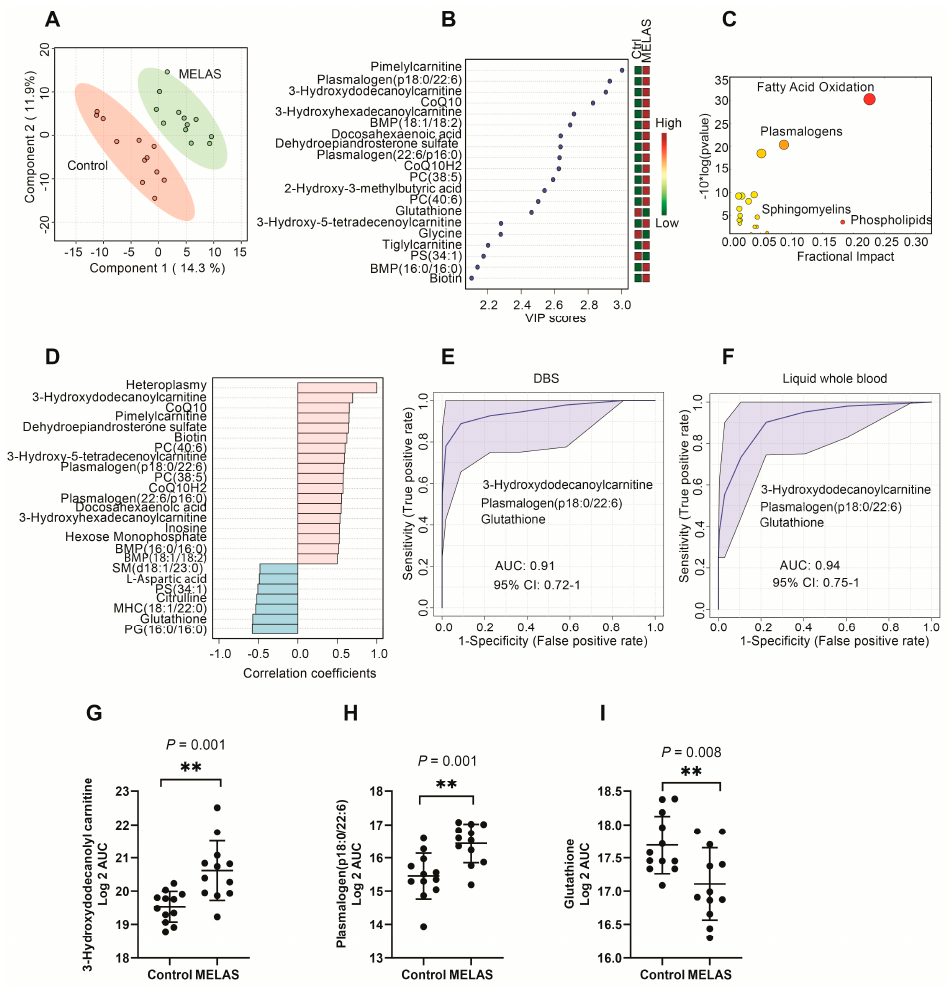
Figure 5. Metabolomic fingerprints and biomarkers in DBS of MELAS patients. ( A ) Partial least squares discriminant analysis (PLS-DA) revealed the complete separation of MELAS patients from the controls (N = 12 / group). ( B ) variable importance in projection (VIP) plot of the top 20